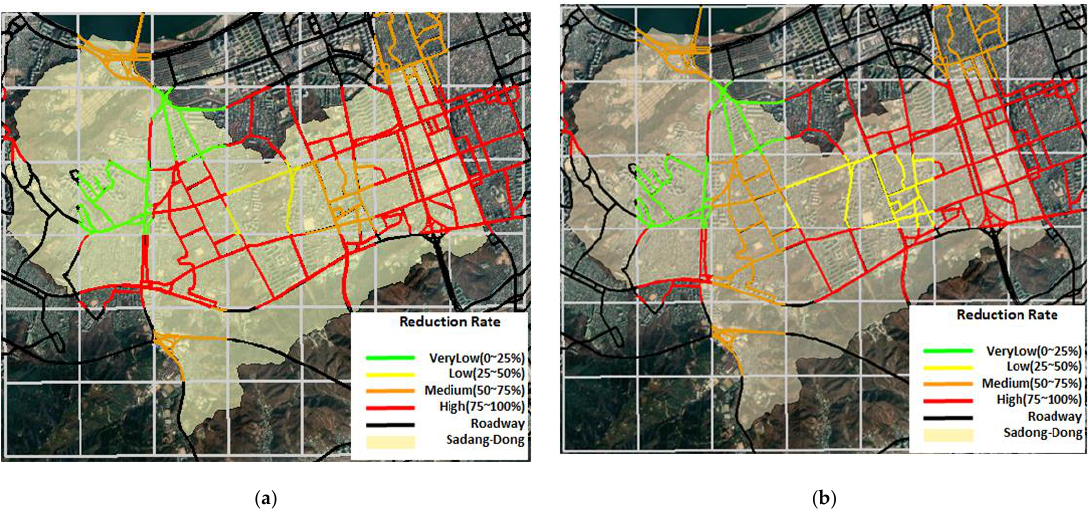
Figure 20. Tra ffi c disruption map using rainfall–vehicle speed relationship. ( a ) Tra ffi c Disruption Figure 20. Traffic disruption map using rainfall – vehicle speed relationship. ( a ) Traffic Disruption Water 2020 , 12 , x Rating of 11.07.27 07:00, ( b ) Tra ffi c Disruption Rating of 11.07.27 09:00. Rating of 11.07.27 07:00, ( b ) Traffic Disruption Rating of 11.07.27 09:00.